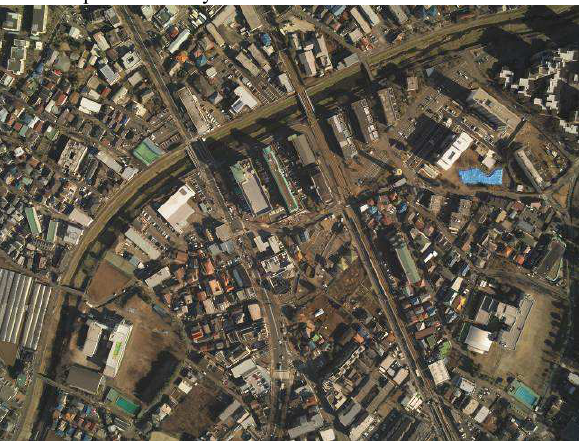
Figure 11. Whole centre